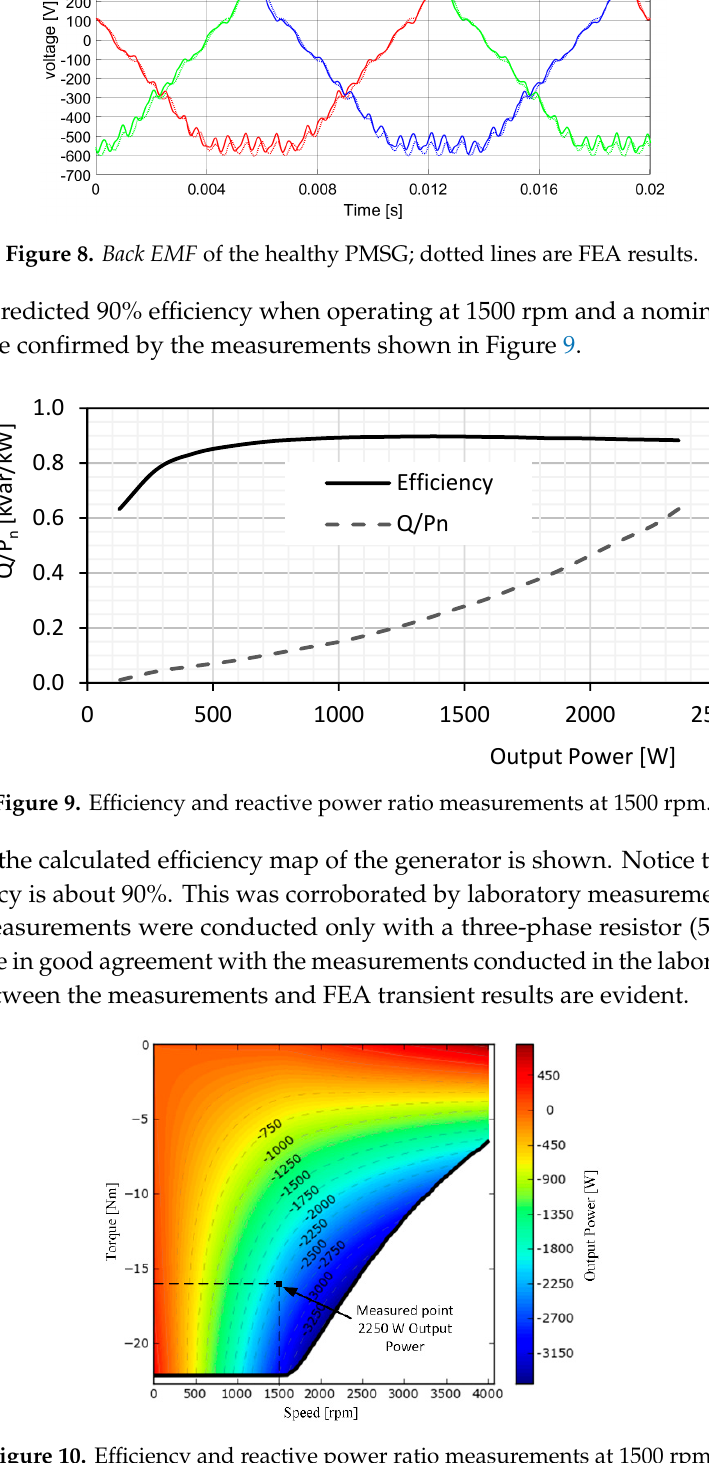
Figure 10. Efficiency and reactive power ratio measurements at 1500 rpm.